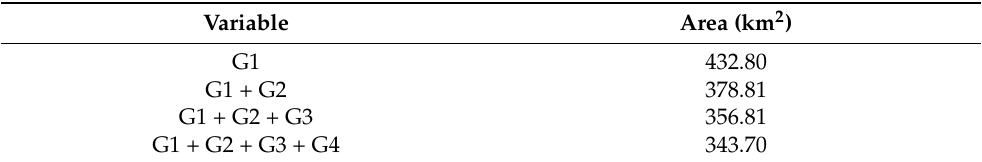
Table 3. Area of PV power plants in Ningxia autonomous region classified from Landsat-8 based model.